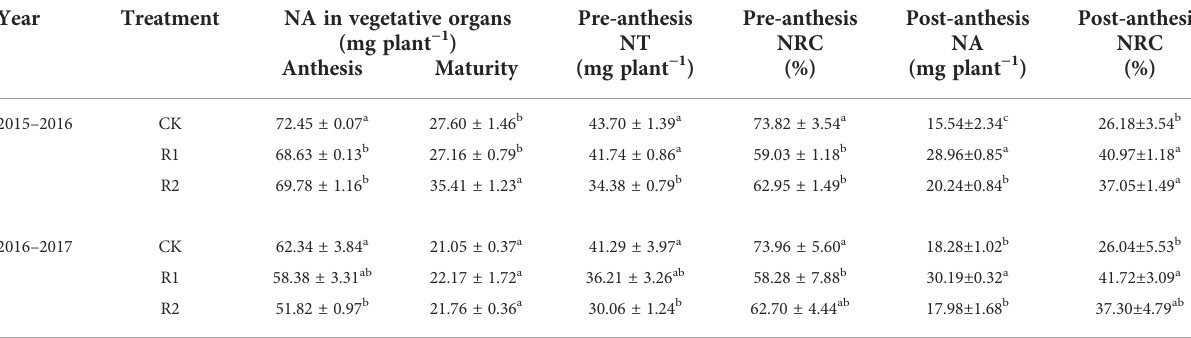
TABLE 6 Nitrogen translocation after anthesis in different row spacing treatments in two